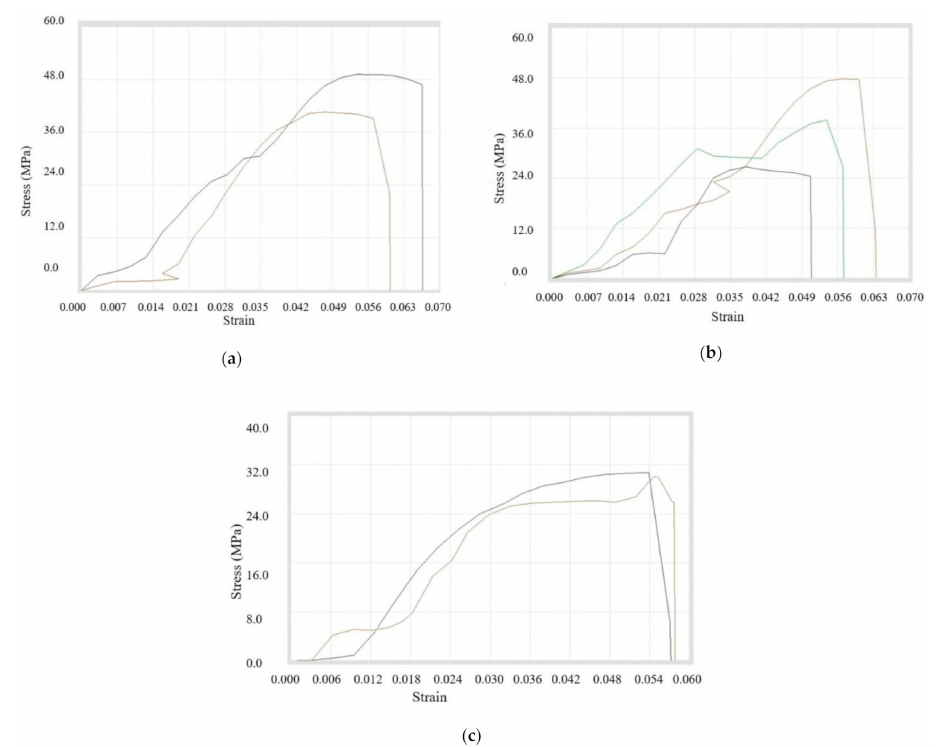
Figure 13. Stress–strain Curves for ( a ) (A + C)4 , ( b ) (A + C)9, and ( c ) (B + C)10 filament samples.